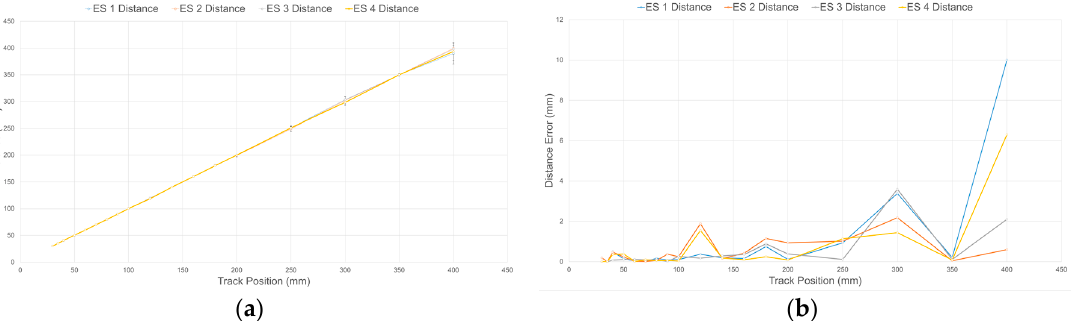
Figure 14. ( a ) Calibrated output of IR range sensors over range of operation and standard deviation on specific calibration points, and ( b ) distance error over range of operation.